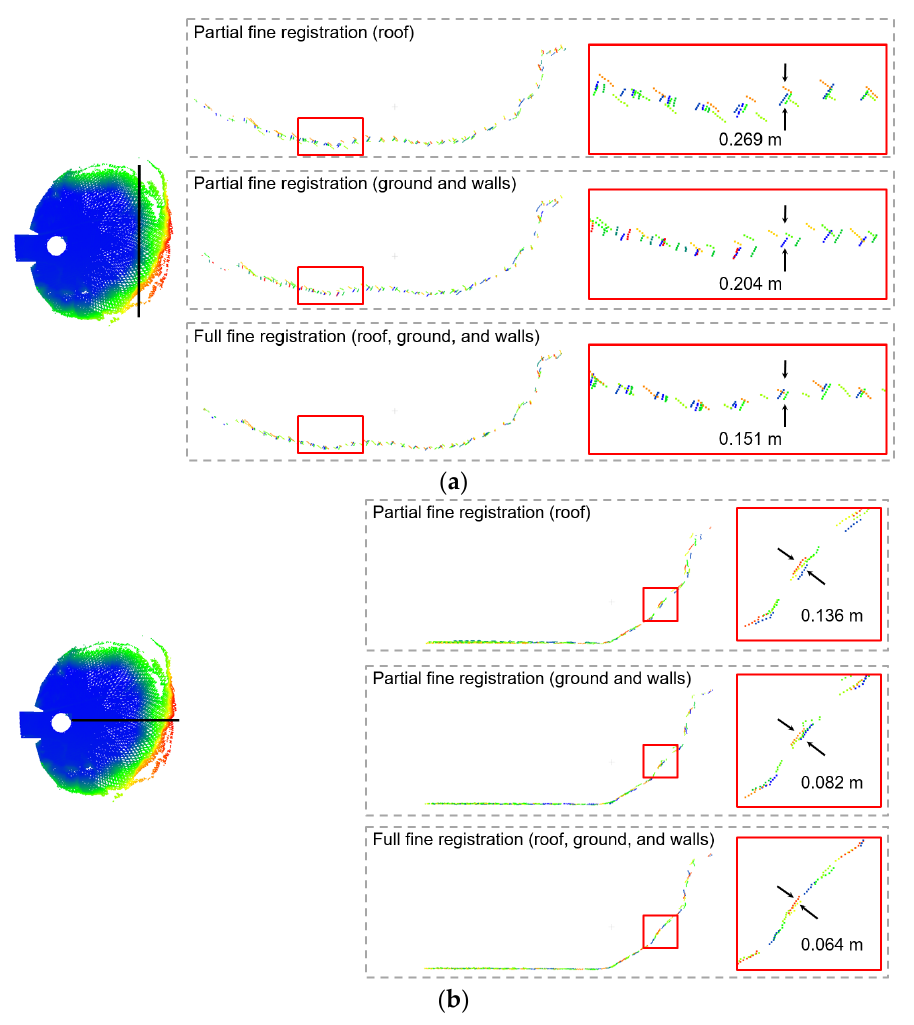
Figure 37. Extracted vertical profiles (width: 0.2 m) from the salt surface of the Frankfort dataset after the partial fine registration using the roof feature, partial fine registration using the ground/wall features, and full fine registration using the roof/ground/wall features (the arrows indicate the direction of the measured distance): ( a ) profile orthogonal to the entrance walls and ( b ) profile parallel to the entrance walls.